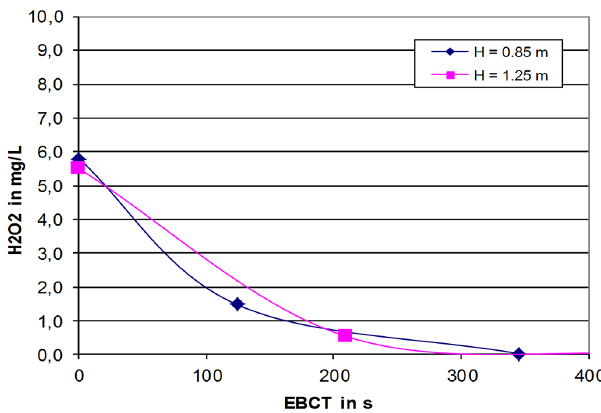
Figure 2. Decomposition over MCFsw in R60s with a bed height of 0.85m (0.6m gravel 0.8–1.2mm and 0.25m anthracite 1.4–2.4mm) and a bed height of 1.25m (1.0m gravel 0.8–1.2mm and 0.25m anthracite 1.4–2.4mm), a flow velocity of 4.4mh − 1 , and a water temperature of 12.4 ◦ C.